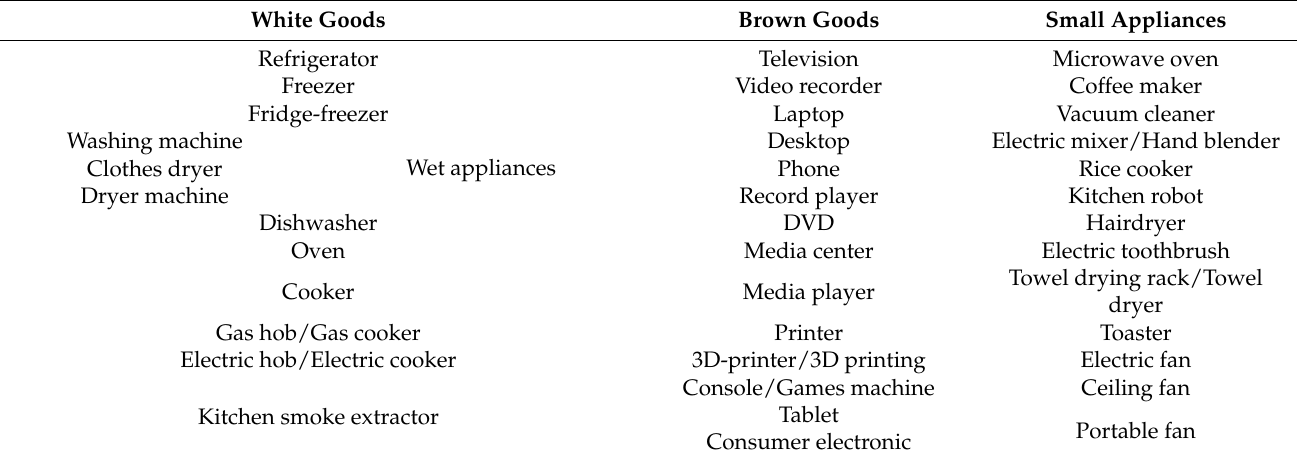
Table 2. Appliances considered in this